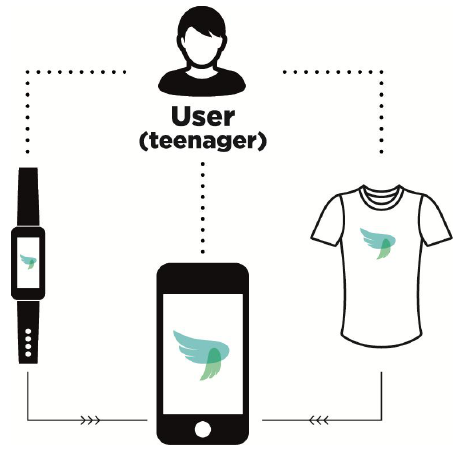
Figure 1. PEGASO sensors system.